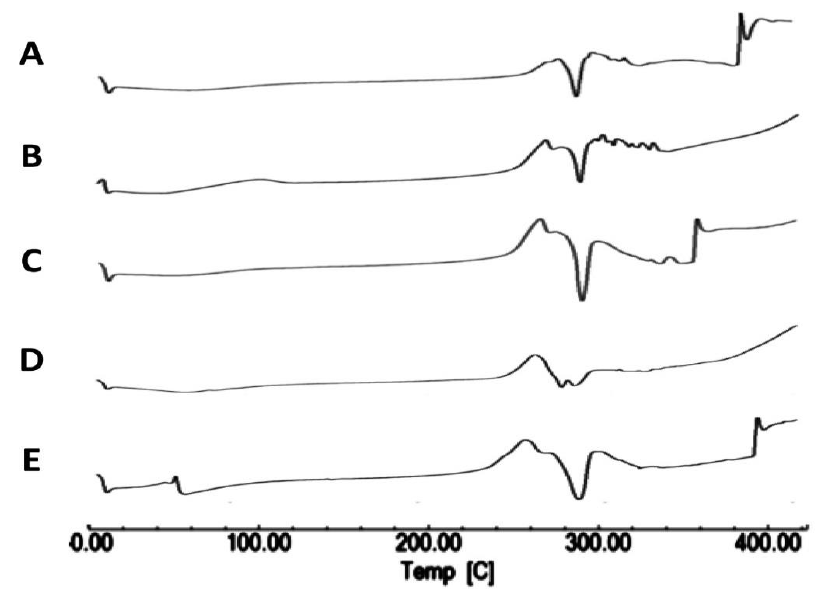
Figure 6. DSC scans of different TAA formulations. ( A ) Micronized TAA raw material unprocessed and ( B ) 1% ( w / v ) TAA/ammonium bicarbonate (90:10), ( C ) (85:15) and ( D ) (80:20) and ( E ) 1.5 ( w / v ) %. TAA/ammonium bicarbonate (90:10) products spray-dried from 90% ( v / v )